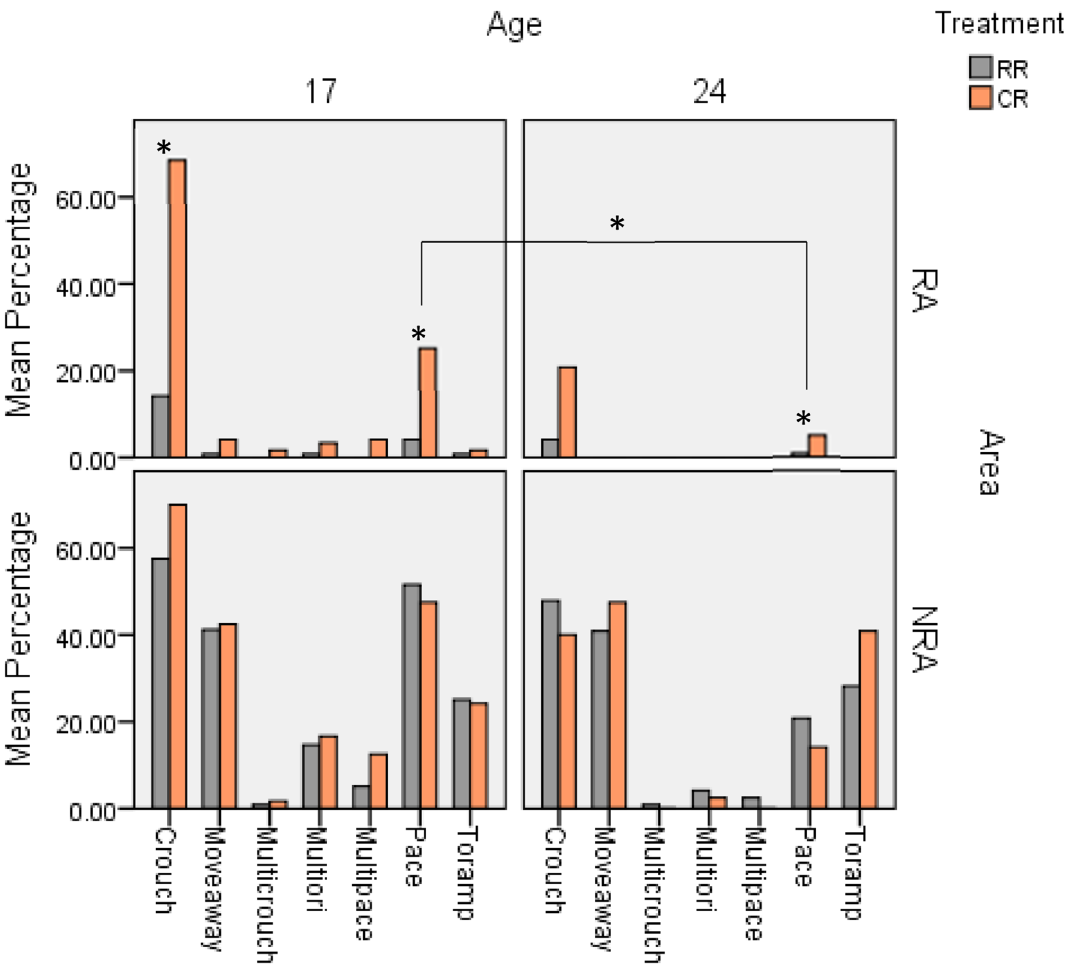
Figure 2. Graphs showing the percentage of focal behaviours for downwards transitions allowing comparisons between age (17 and 24 weeks of age), area (ramp area = RA or no ramp area = NRA) and treatment (ramp reared = RR and control reared = CR). Significant differences between the rearing treatments and age are indicated by an asterisk